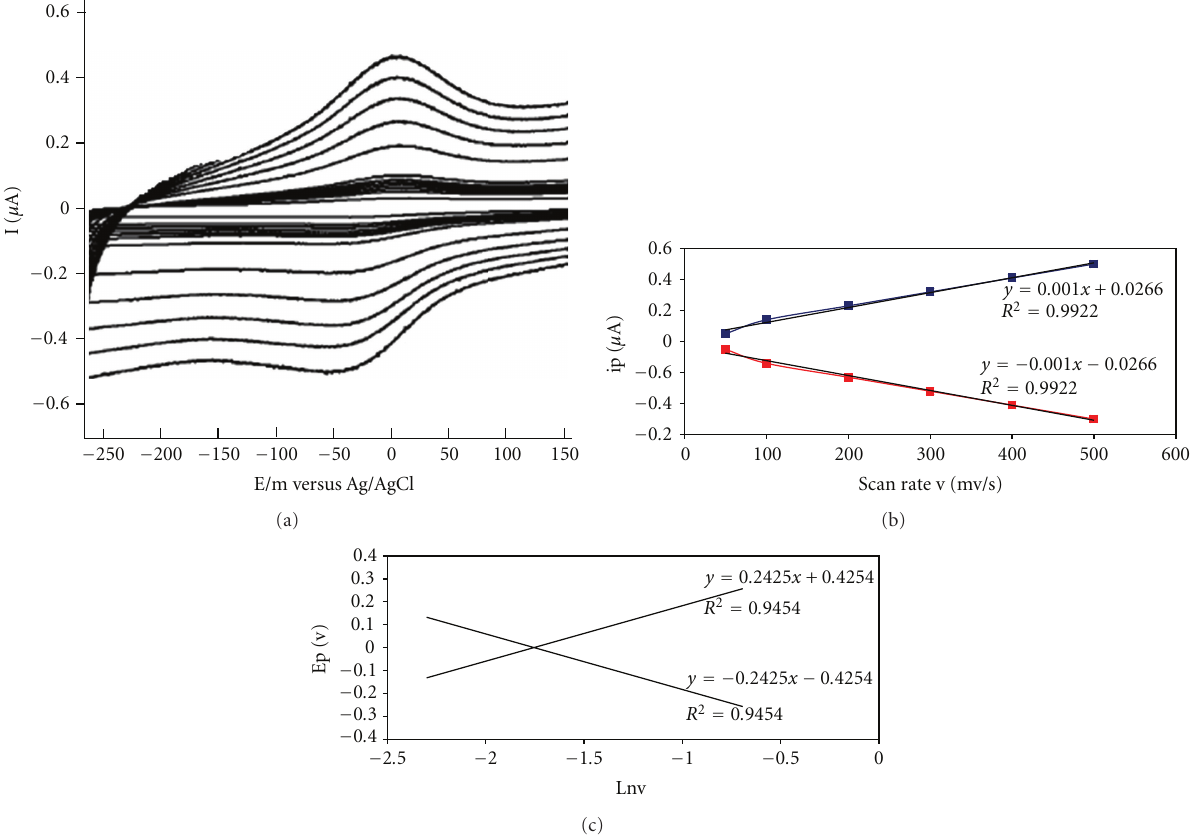
Figure 5: (a) Typical cyclic voltammograms of Hb/Mn 2 O 3 -Ag nanofibers/glassy carbon electrode at di ff erent scan rates. The voltammo- grams (from inner to outer) designate scan rates of 50, 100, 200, 300, 400, and 500 mVs − 1 , respectively. (b) Dependence of the anodic and cathodic peak currents on the scan rates the red line is cathodic and the blue line is anodic. (c) Relationship between the peak potential ( E p ) and the natural logarithm of scan rate (ln v ) for Hb/Mn 2 O 3 -Ag nanofibers/glassy carbon electrode. All the data were obtained at pH 7.0 and in 0.1M phosphate bu ff er